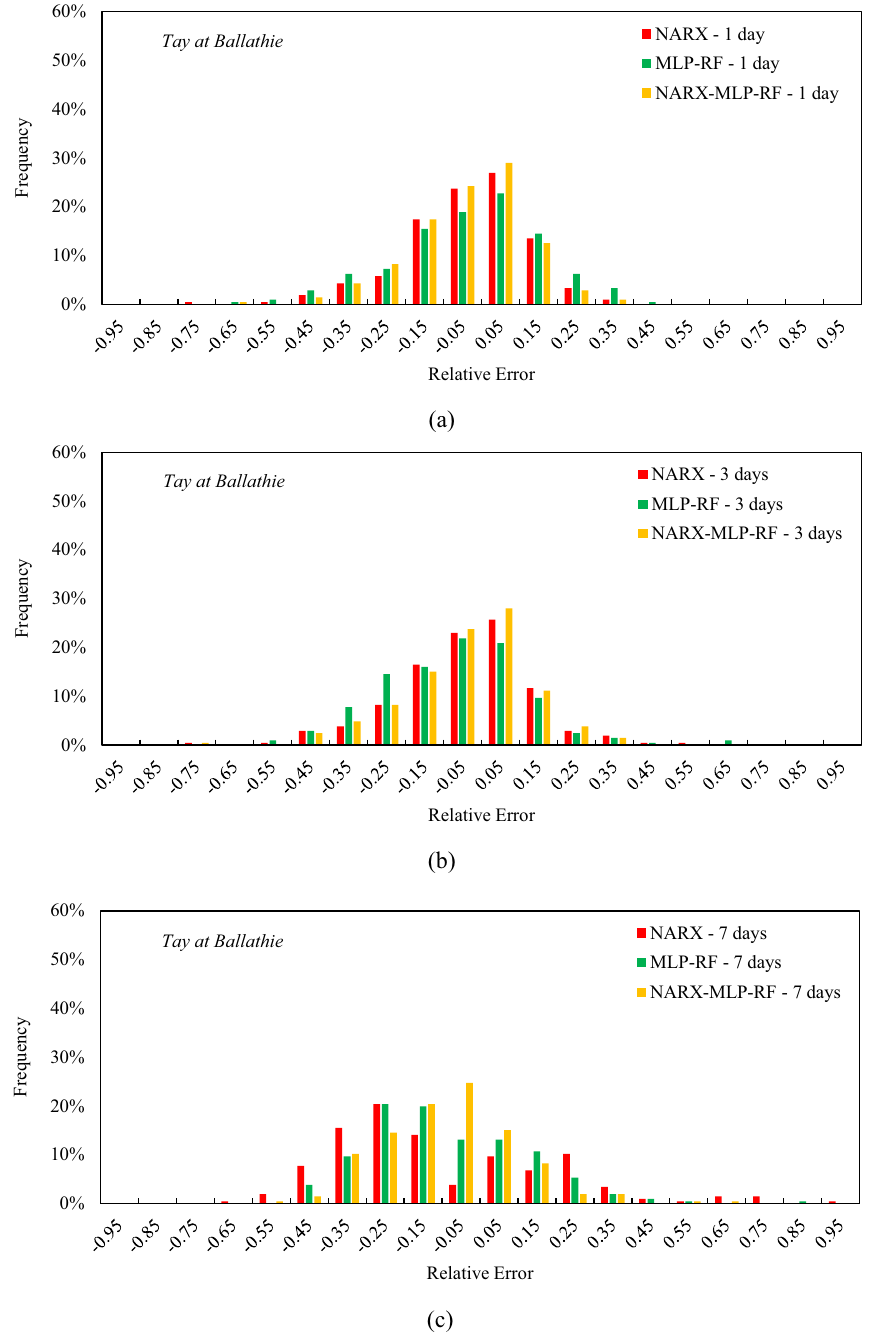
Figure 11. Frequency of the relative error for the tenth decile for Tay at Ballathie: t = 1 day ( a ); t = 3 days ( b ); t = 7 days ( c